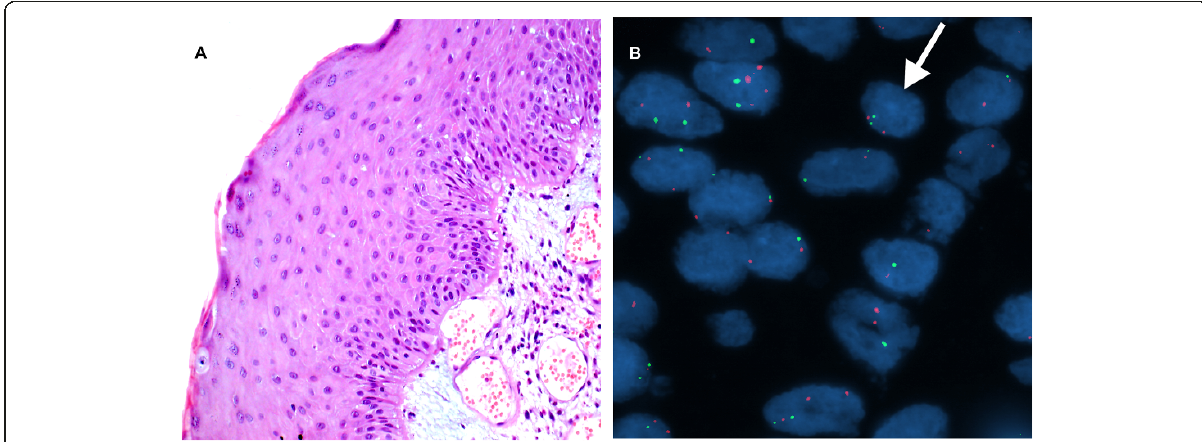
Figure 2 A case of mild dysplasia of the larynx . A. H&E stain. (×200). B. Interphase FISH displaying a CSP3: hTERC signal pattern of 2:2 (green: red). ( × 1000).